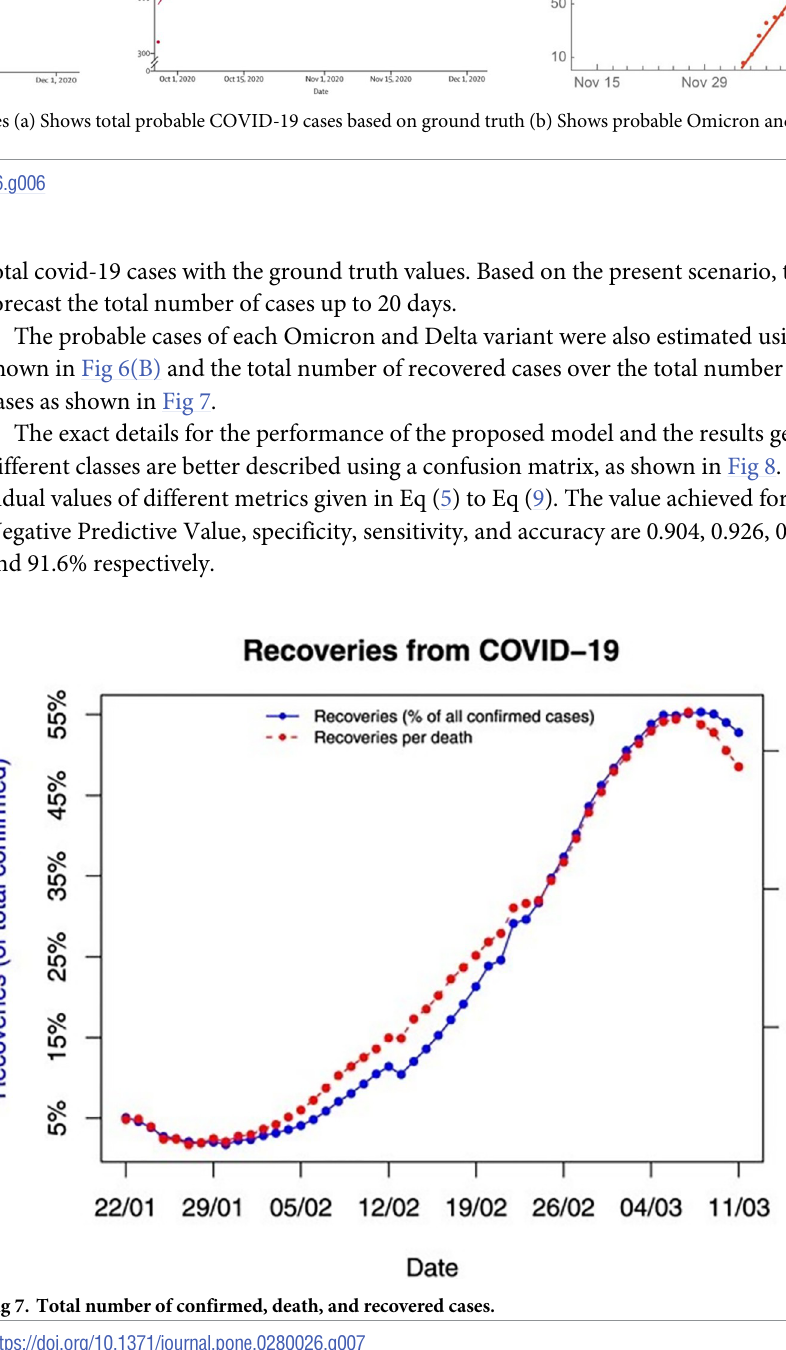
PLOS ONE | https://doi.org/10.1371/journal.pone.0280026 March 24,